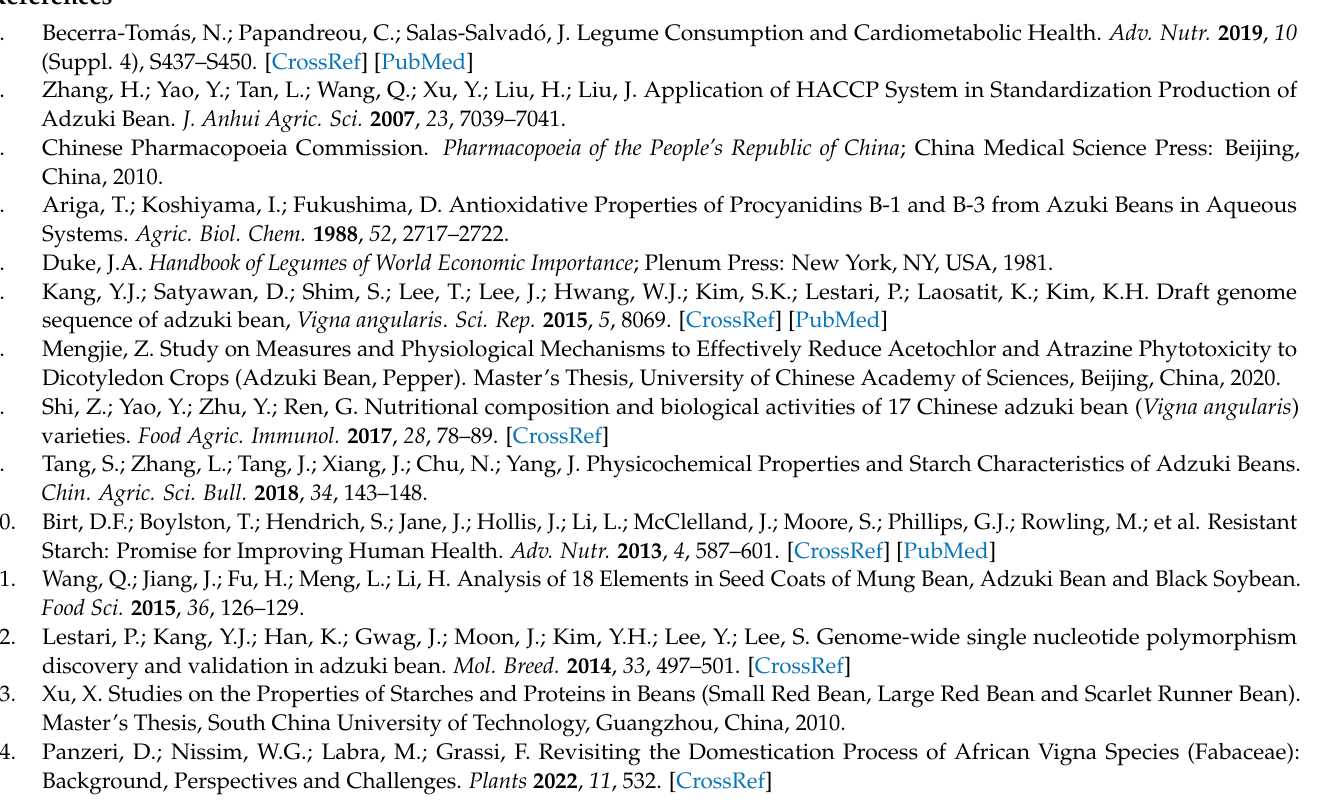
Figure made by software, X.S. and F.W.; editing, X.Z. and Z.L.; project administration, K.C. and